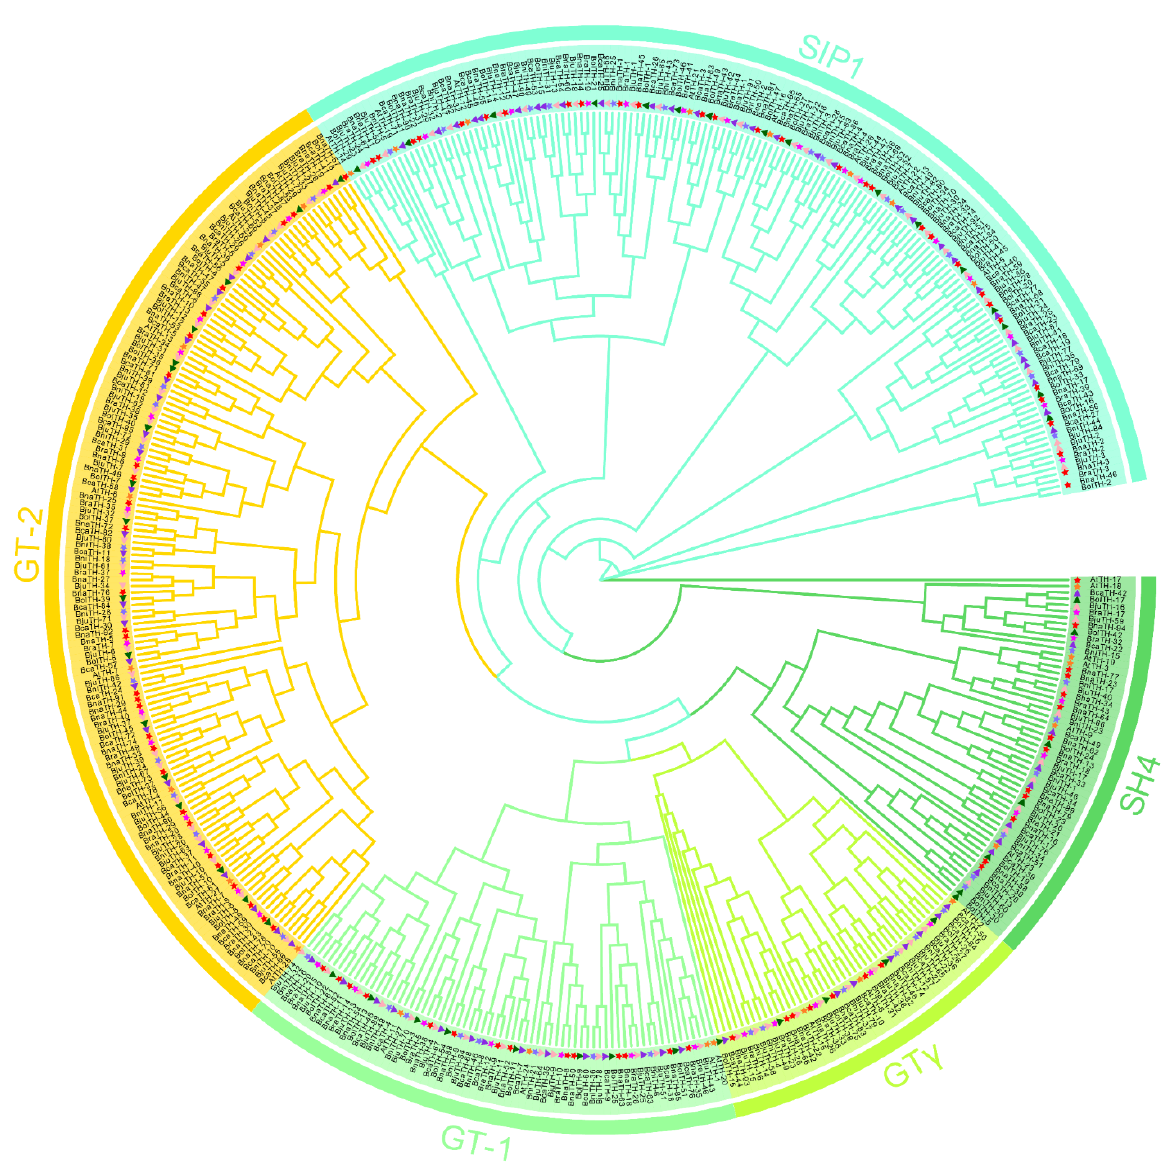
Figure 1. Phylogenetic tree using 455 TH proteins from 7 species, including Arabidopsis , B. carinate , B. juncea , B. napus , B. oleracea , B. nigra , B. oleracea , and B. rapa , marked as yellow pentagram, purple triangle, pink triangle, red pentagram, purple pentagram, green triangle, and purple pentagram, respectively. The clades of group GT-1, GT-2, GT γ , SH4, and SIP1 are distinguished by different colors.